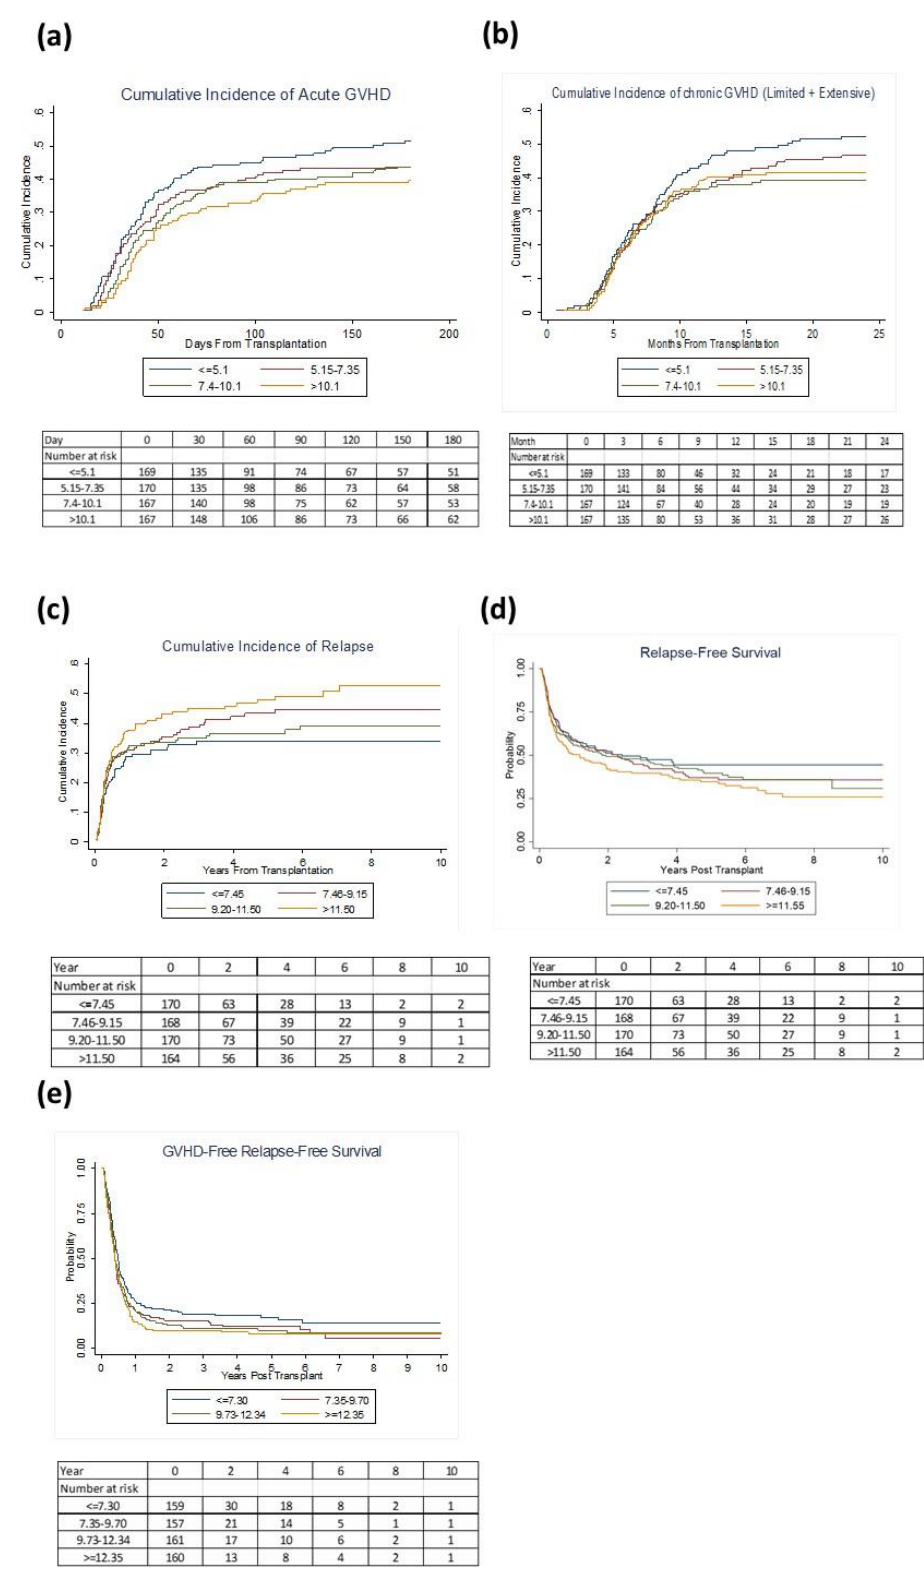
Figure 2. Association of TAC levels with the cumulative incidence of ( a ) grade II-IV aGVHD, ( b ) cGVHD, ( c ) relapse, and probability of ( d ) relapse free survival, ( e ) GVHD free relapse free